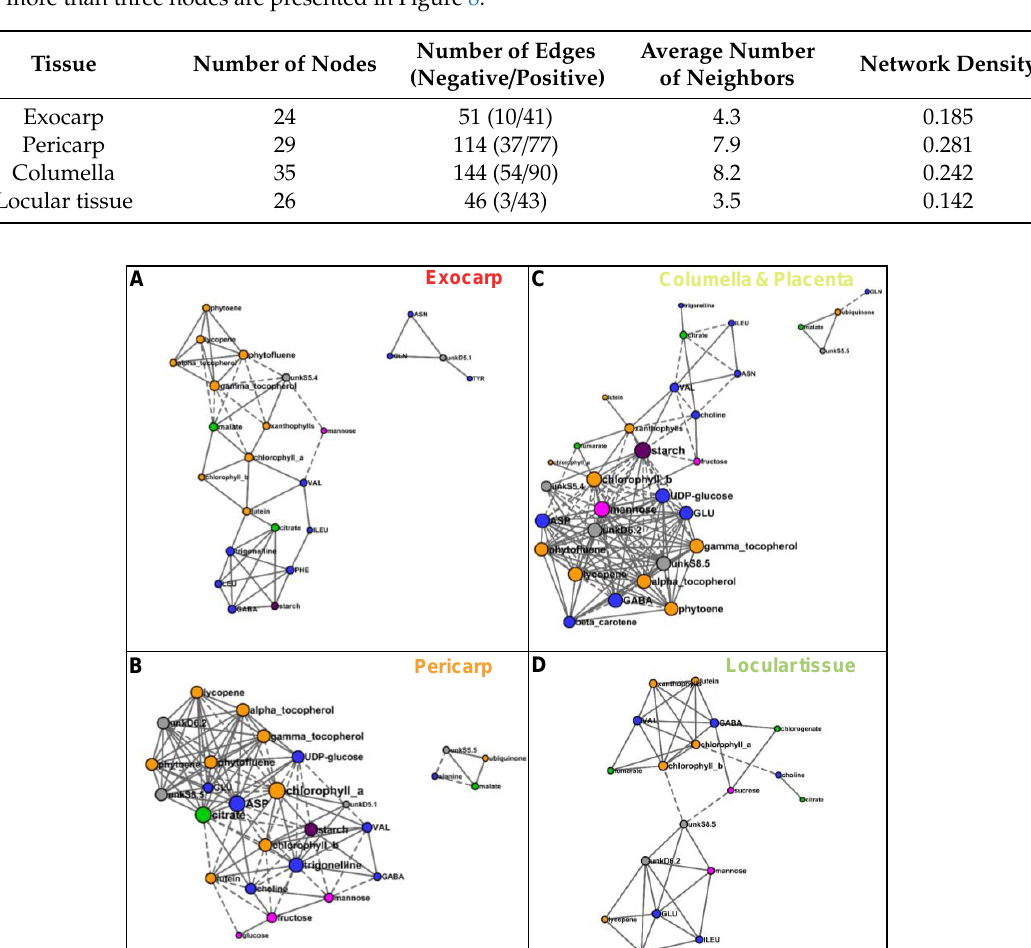
Figure 8. Correlation networks based on the absolute values of 39 metabolites and starch measured by 1 H-NMR, LC-DAD, or enzymatic analyses and expressed on a DW basis, for each of four tissues. Correlations were filtered based on their significance with a false discovery rate correction (q < 0.001) and visualized using Cytoscape for the sub-networks comprising more than three nodes. ( A ) Exocarp. ( B ) Mesocarp with endocarp. ( C ) Columella with placenta. ( D ) Locular tissue. Metabolites are colored according to their biochemical family: sugars in pink, organic acids in green, amino acids and other amino compounds in blue, isoprenoids in orange, and starch in purple. Full line, positive correlation; dashed line, negative correlation. The size of each node is proportional to its number of edges.